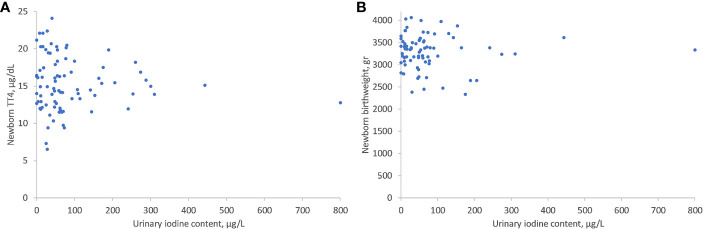
Correlations between UIC and neonatal TT4 (A) and neonatal birth weight (B). UIC, Urinary iodine concentration; TT4, Total T4.